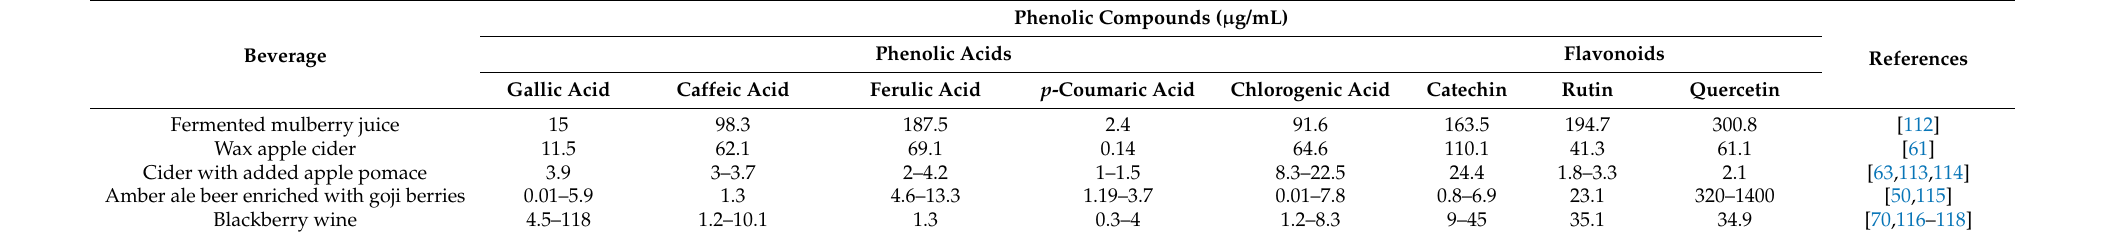
Table 1. Concentration of the main phenolic compounds found in different fruit-based fermented